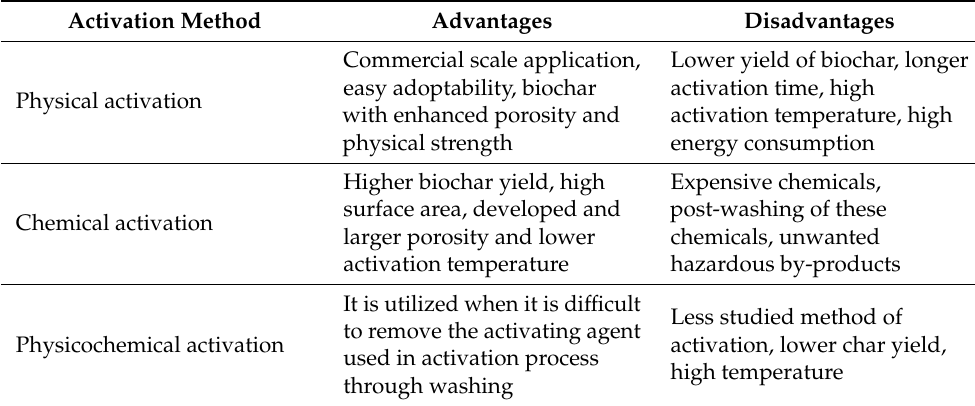
Table 2. Advantages and disadvantages of activation